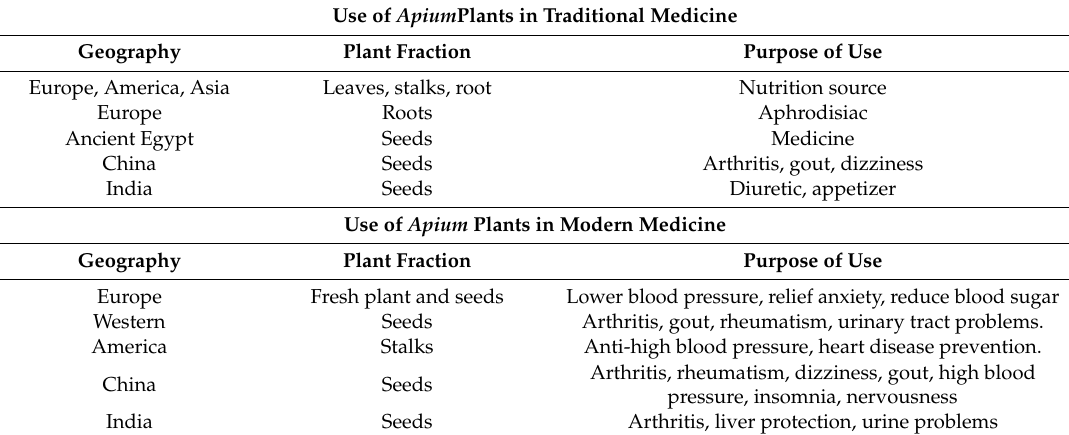
Table 3. Use of Apium plants in traditional and modern medicine